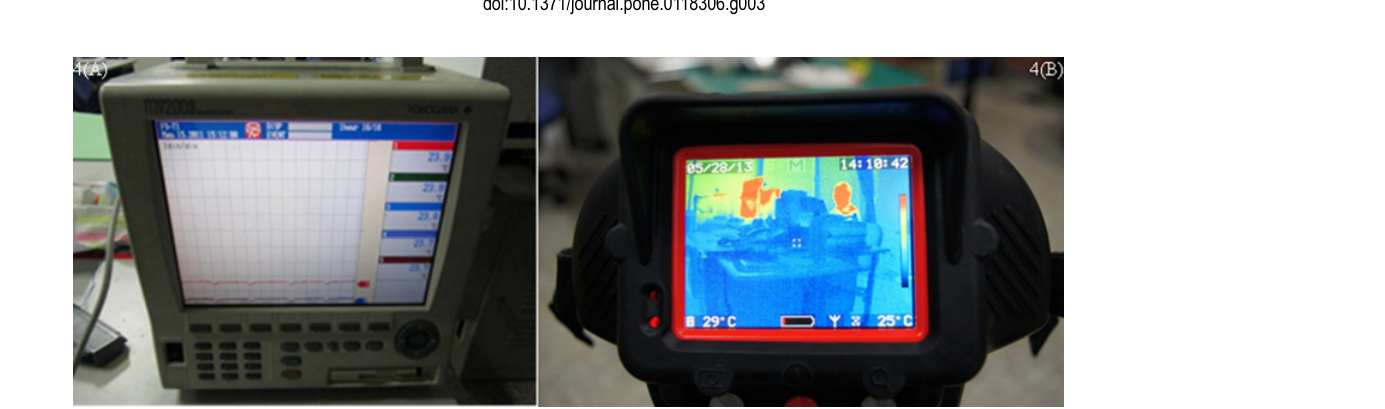
Fig 3. A: Combustion conditions of wood. B: Water spraying situation on the site.